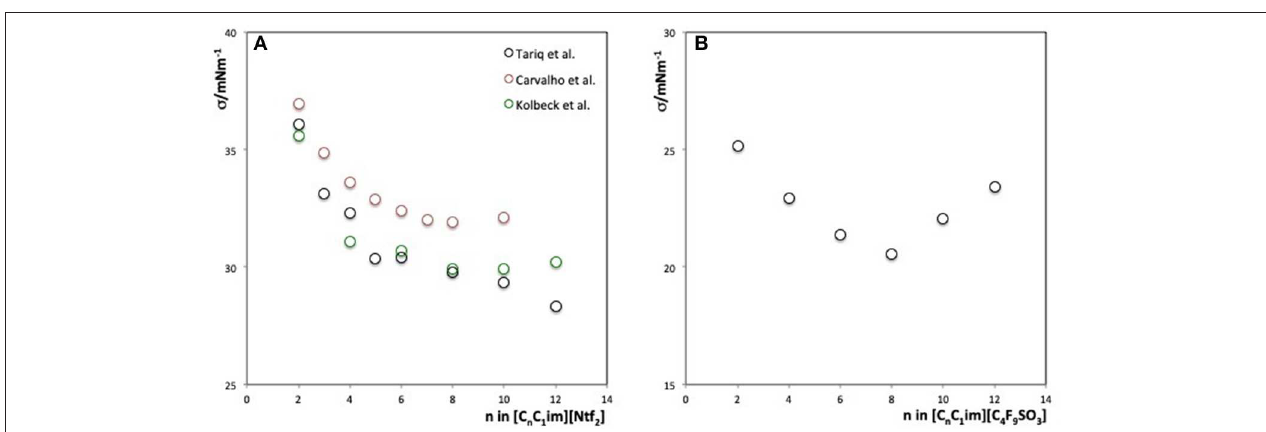
FIGURE 4 | (A) Surface tension values vs. the size of the alkyl chain, n , for [C n C 1 im][Ntf 2 ] family from different authors measured at 293K showing clearly a break around C 5 -C 6 . (B) Surface tension values as a function of the alkyl chain, n , for the [C n C 1 im][C 4 F 9 SO 3 ] family at 313K. (Reprinted with permission from Luís et al., 2016. Copyright (2016) American Chemical Society).